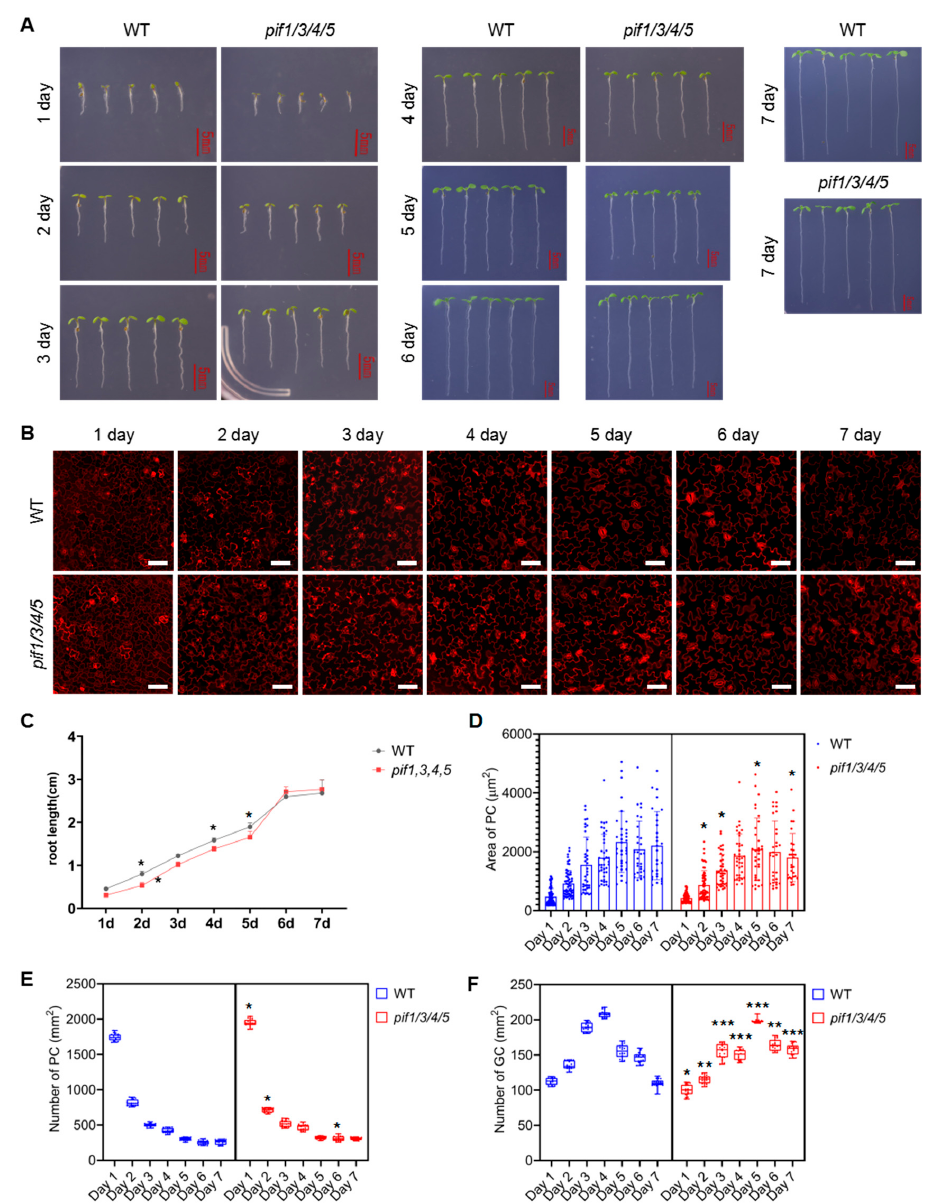
Figure 5. Analysis of the development of pavement cells (PCs) and guard cells (GCs) in pif1/3/4/5 and WT under normal conditions. ( A ) Analysis of the growth of pif1/3/4/5 and WT under control conditions. The seedlings of pif1/3/4/5 and WT were grown in 1/2 MS plates for 1–7 days; the growth phenotype was recorded by photos; untreated seedlings were used as controls. Scale bar: 5 mm. ( B ) Detection of the development of PC and GC under the following conditions: The seedlings of pif1/3/4/5 and WT were grown in 1/2 MS plates for 1–7 days and then harvested and stained with propidium (PI) for 30 min to stain the membranes. After PI staining, the lower epidermis of cotyledons of seedlings was subjected to detect PC and GC’s developmental state on a laser confocal microscope. Scale bar: 50 µ m. ( C ) Statistical analysis of the root length of seedlings of pif1/3/4/5 and WT ( n = 5). ( D ) Statistical analysis of PC area in lower epidermis of cotyledons of seedlings of pif1/3/4/5 and WT ( n = 50). ( E ) Statistical analysis of the number of PC in lower epidermis of cotyledons of seedlings of pif1/3/4/5 and WT ( n = 10). ( F ) Statistical analysis of the number of GC in lower epidermis of cotyledons of seedlings of pif1/3/4/5 and WT ( n = 10). The data were analyzed by one-way ANOVA following Brown–Forsythe test. *: p < 0.05; **: p < 0.01; ***: p <